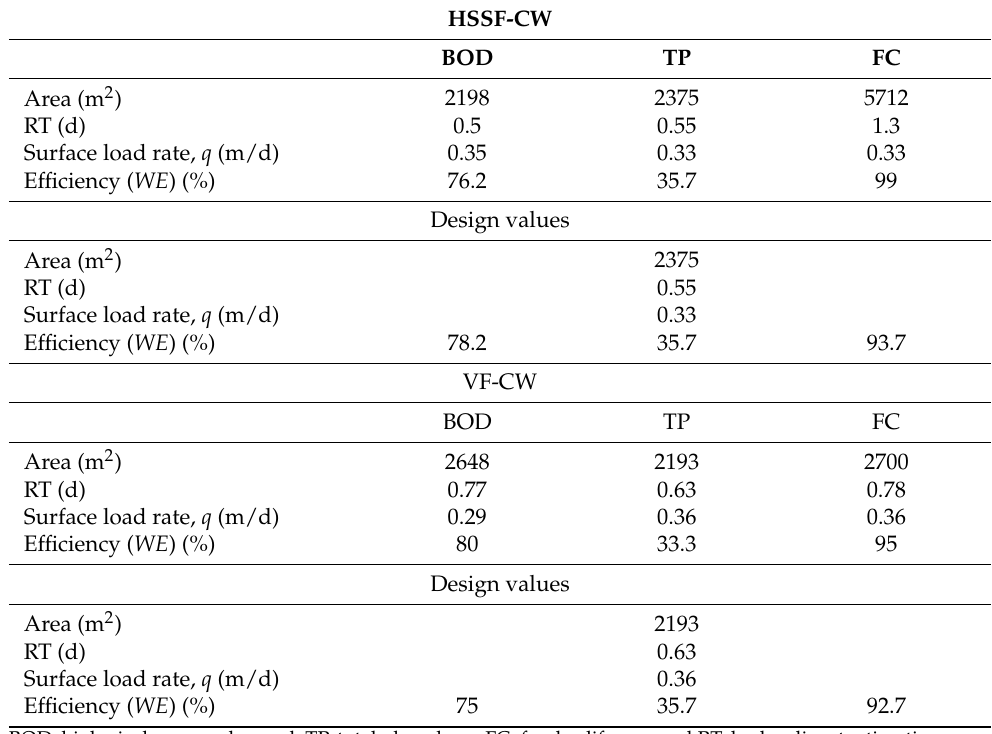
Table 3. Model output results for HSSF and VF-CWs.